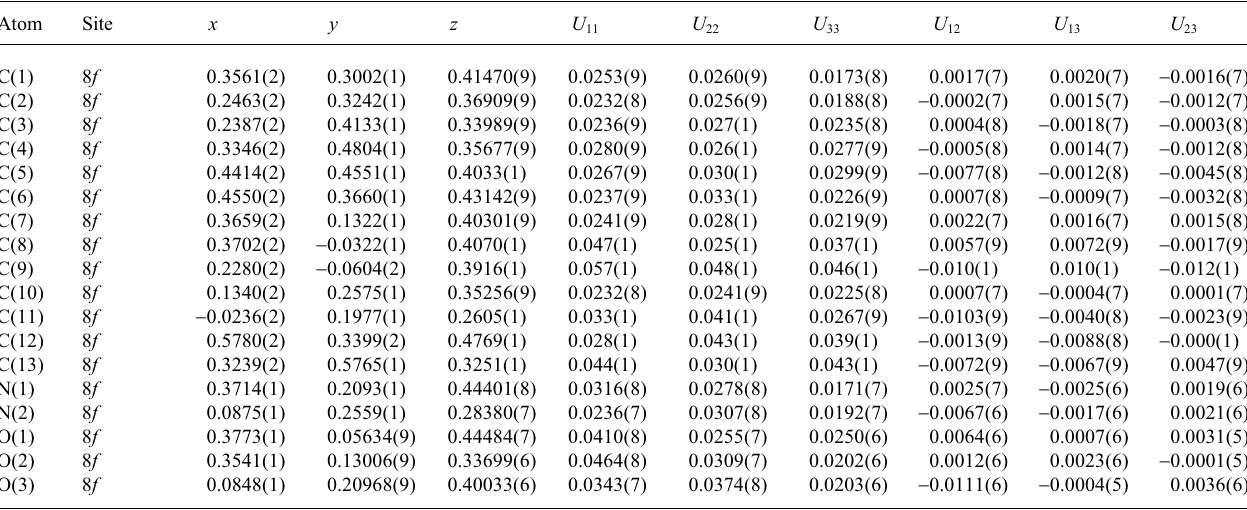
Table 3. Atomic coordinates and displacement parameters (in Å 2 )